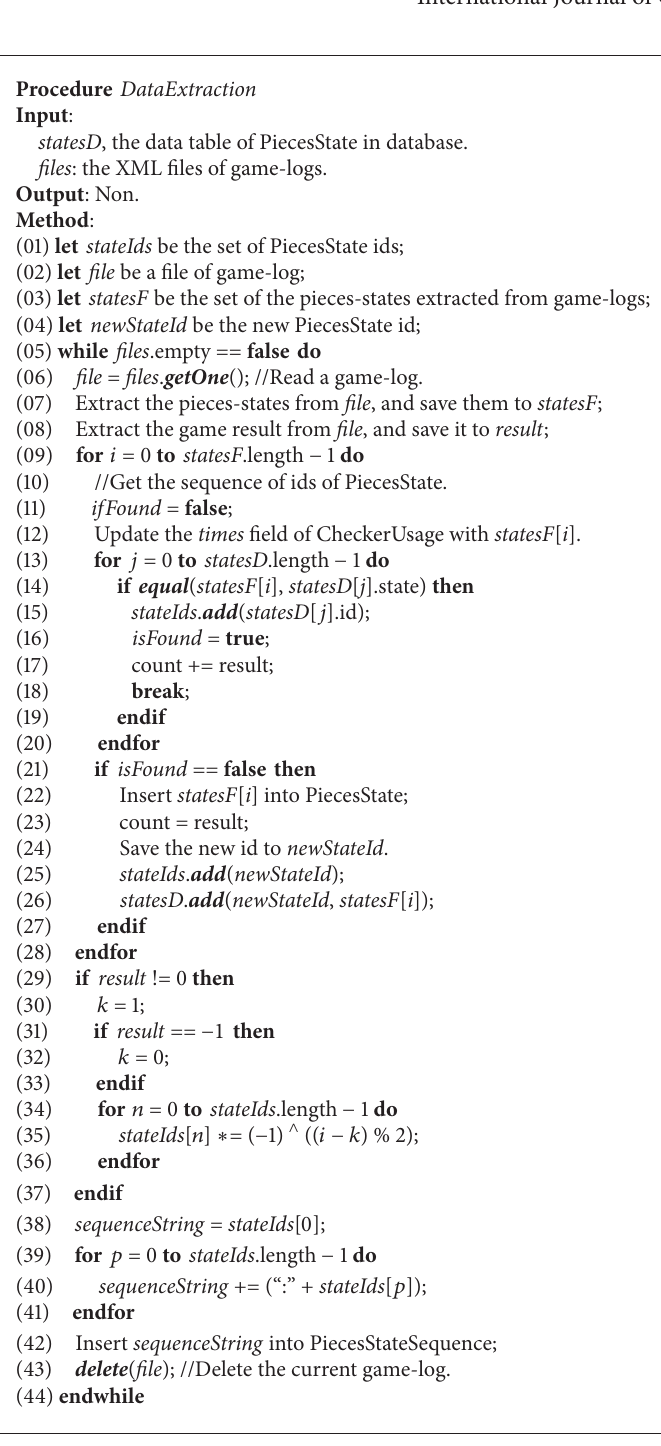
Algorithm 1: DataExtraction